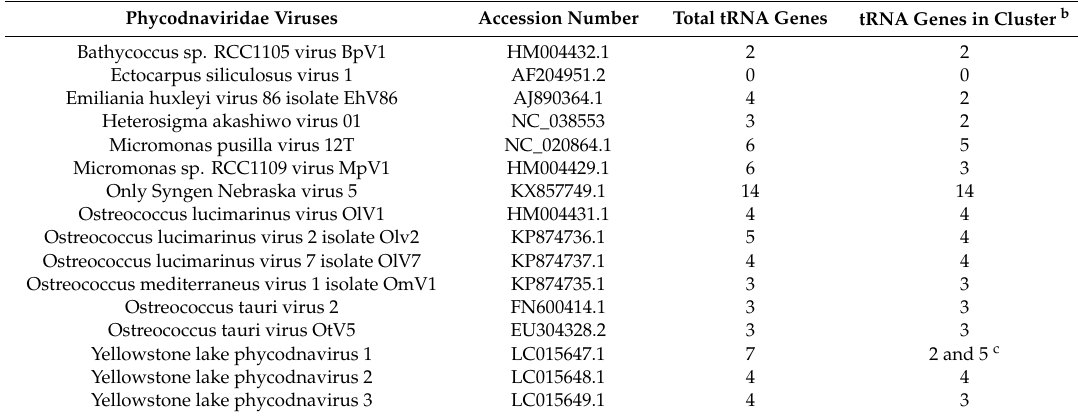
Table 6. Total tRNA genes and clusters of representative Phycodnaviridae viruses a